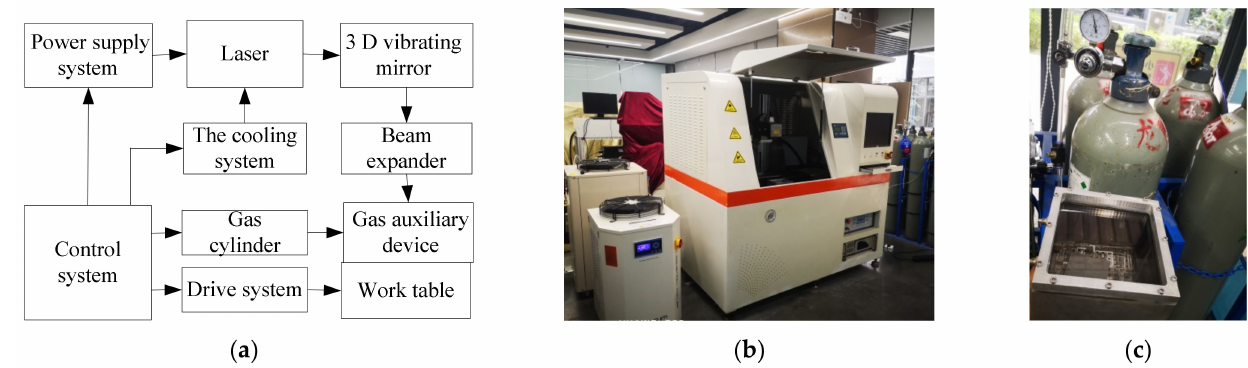
Figure 8. Laser cleaning machine equipment. ( a ) Schematic diagram of laser cleaning, ( b ) photograph of the laser cleaning equipment, ( c ) gas auxiliary device.